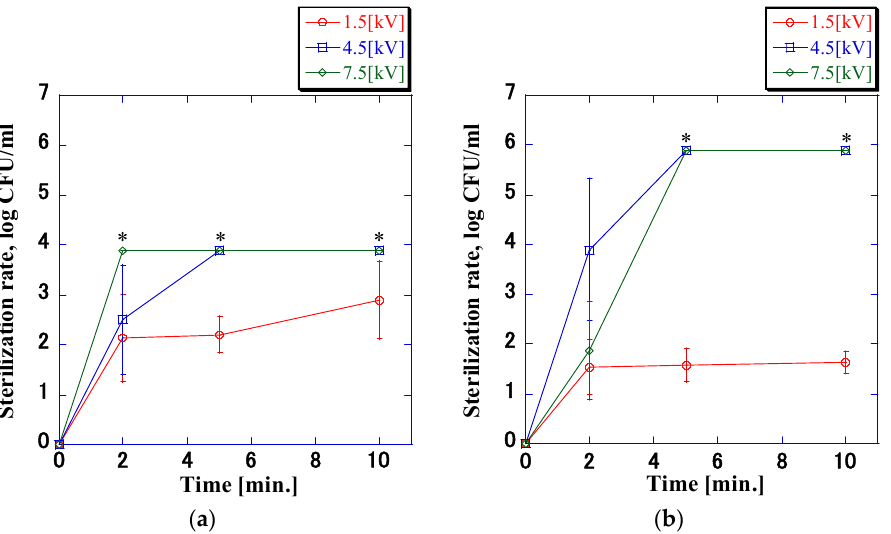
Figure 6. VRE sterilization rate at impulse voltage application times of up to 10 min (pulse width: 6.9 μ s). The sterilization rate increased with the application time. In addition, there was a change in the sterilization ratio between the applied voltages 4.5 kV and 1.5 kV. There was no difference be ‐ tween the sterilization rates of the initial concentrations. Values calculated with the counts below the detection limit of quantification are marked with an asterisk; ( a ) 8.0 × 10 3 CFU/mL; ( b ) 8.0 × 10 5 CFU/mL. 3.3. Sterilization by Impulse Voltage with Rapid Buildup Next, the circuitry of the impulse voltage generator was changed to apply impulse voltages with rapid buildup to the VRE . The corresponding voltage and current wave ‐ forms are shown in Figure 7. The voltage waveform buildup time was 0.2 μ s, and the decay time was 4 μ s. A comparison with the results presented in Section 3.2 revealed that the decay time was the same; however, the buildup time was considerably shorter. The current waveform had the same shape as that of the voltage waveform, as indicated in Section 3.2. Figure 8 shows the sterilization rate when different impulse voltages were applied to the different cell densities. The higher the application voltage was, the higher the sterili ‐ zation rate. There was a large difference between the sterilization rates achieved with ap ‐ plication voltages of 7.5 kV and 4.5 kV compared to those achieved with an application voltage of 1.5 kV. In particular, complete sterilization was not achieved at an application voltage of 1.5 kV. Additionally, the pH of the bacterial suspension did not change signifi ‐ cantly at any voltage. These results were consistent with those reported in Section 3.2.